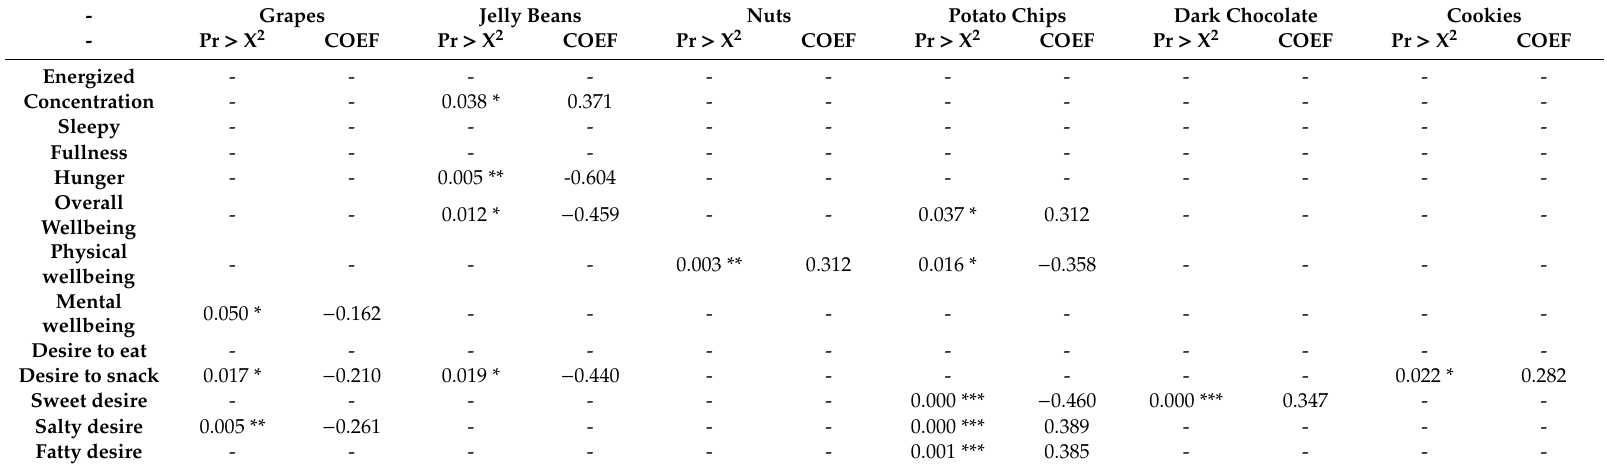
Table 5. The e ff ect of subjective sensations on each snack choice including significant p -values and positive / negative coe ffi cient values (COEF) from binomial logistic regression